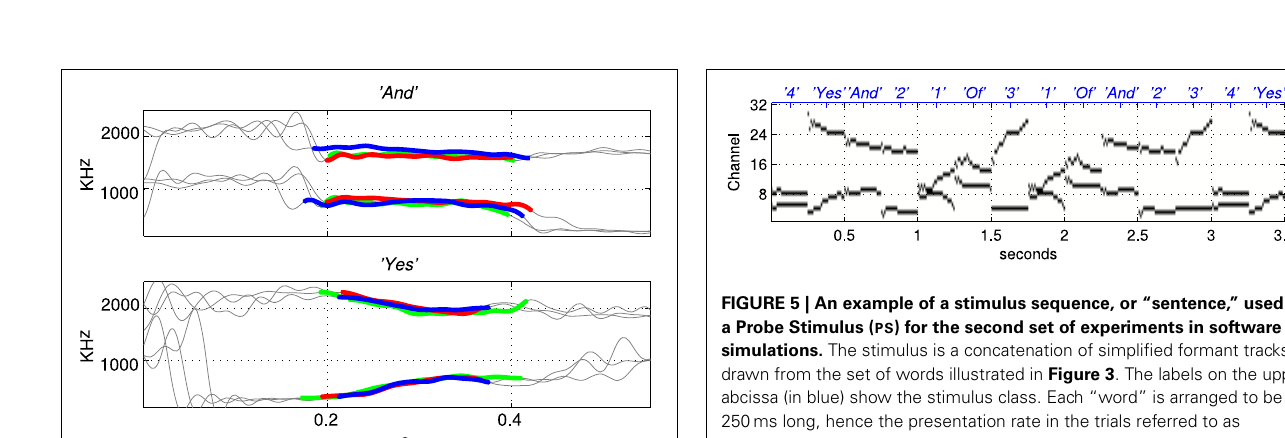
gray) are the parts of the sound files that were silent or contained consonants. Formant tracks of vowels, shown in thicker blue line segments, were smoothed and down-sampled to produce the patterns of current injection that were a highly simplified representation of the speech stimuli, see Figure 5 .